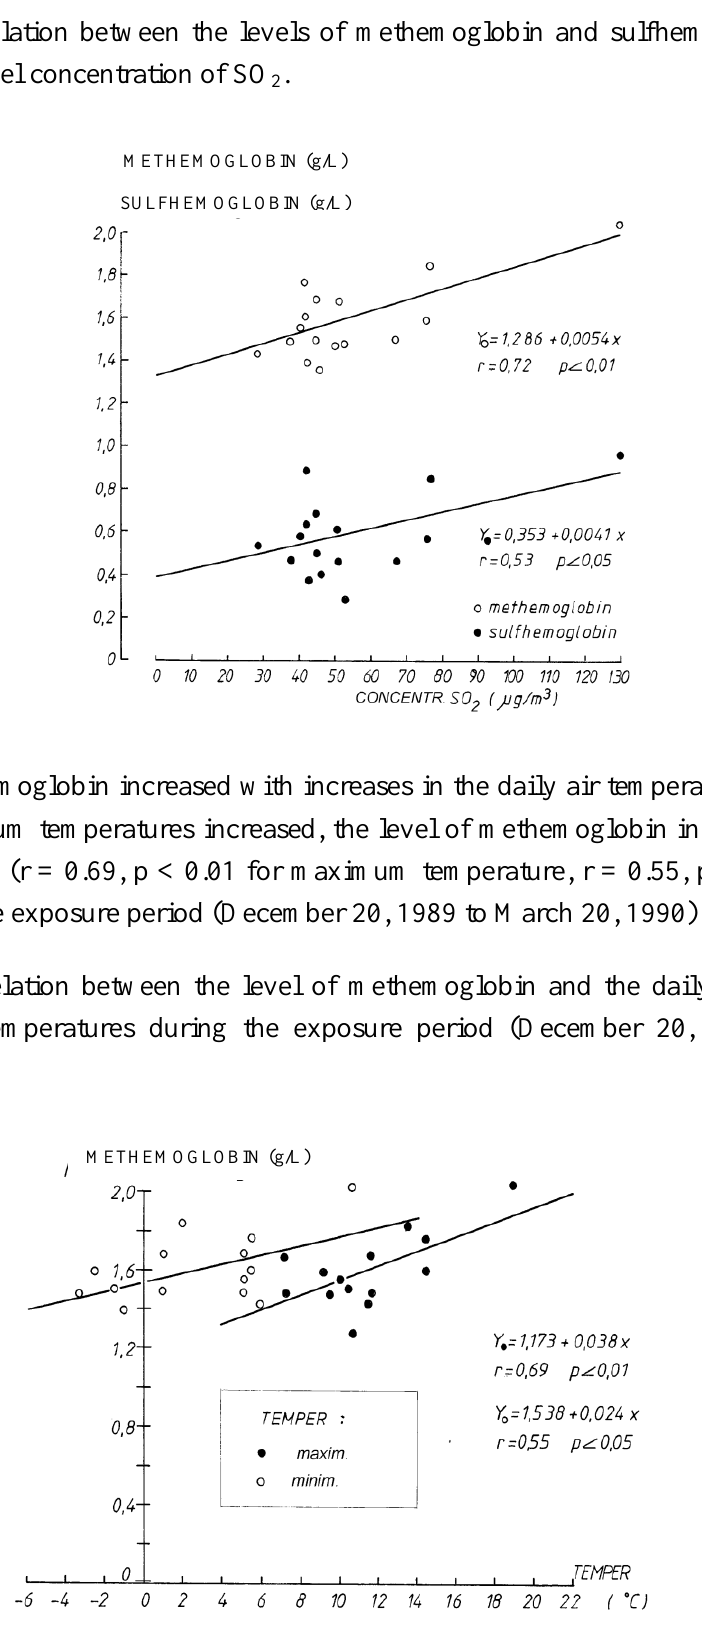
Figure 1. Correlation between the levels of methemoglobin and sulfhemoglobin and the daily ground-level concentration of SO